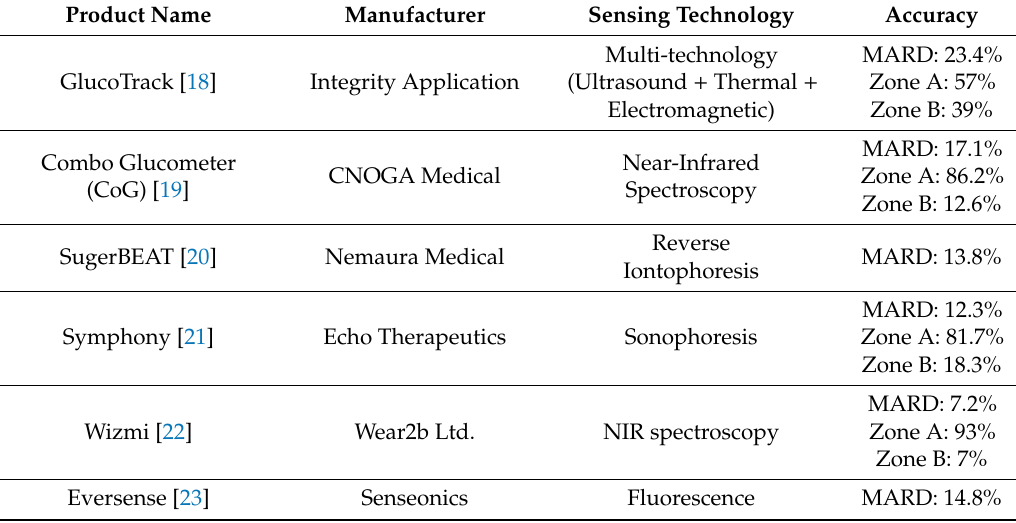
Table 4. Non-invasive and minimally-invasive blood glucose monitors with their